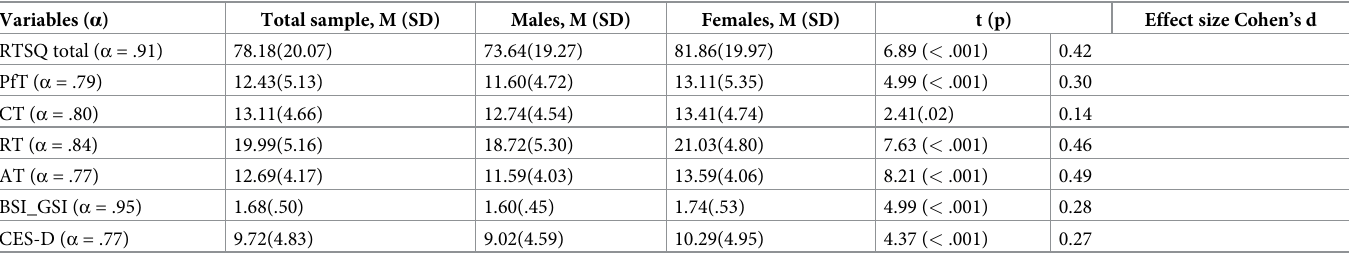
Table 6. Means and standard deviations of the variables, along with t-statistics and effect sizes by gender. Variables ( α ) Total sample, M (SD) Males, M (SD) Females, M (SD) RTSQ total ( α = .91)